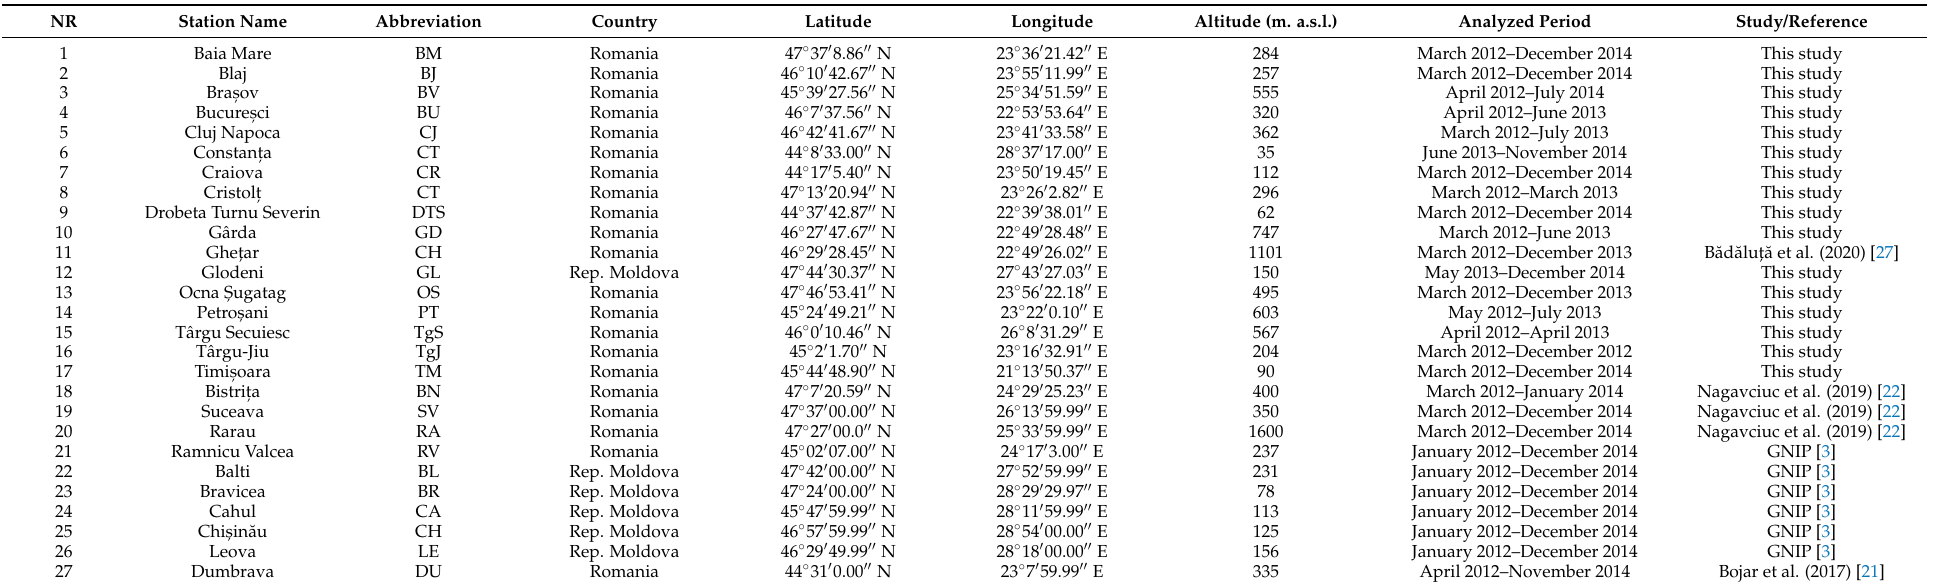
Table 1. The names of the study sites for measurement samples, with the corresponding abbreviations, country, coordinates, elevations, analyzed periods, and the data